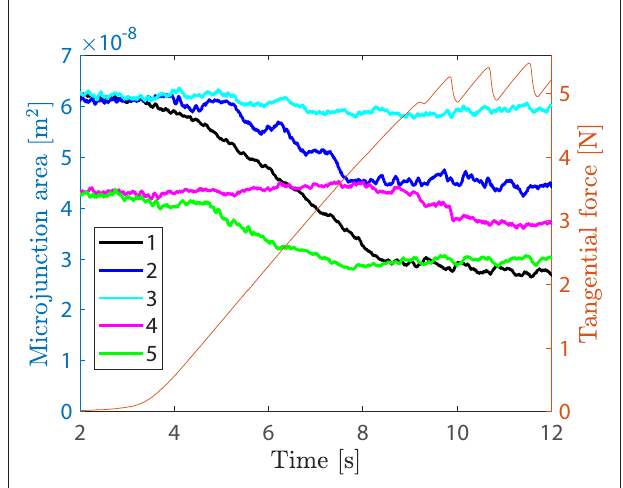
FIGURE 2 | Left axis: time evolution of the contact area A i of five typical microjunctions in the experiment at P = 4.01 N. Right axis: concurrent evolution of the macroscopic tangential force Q